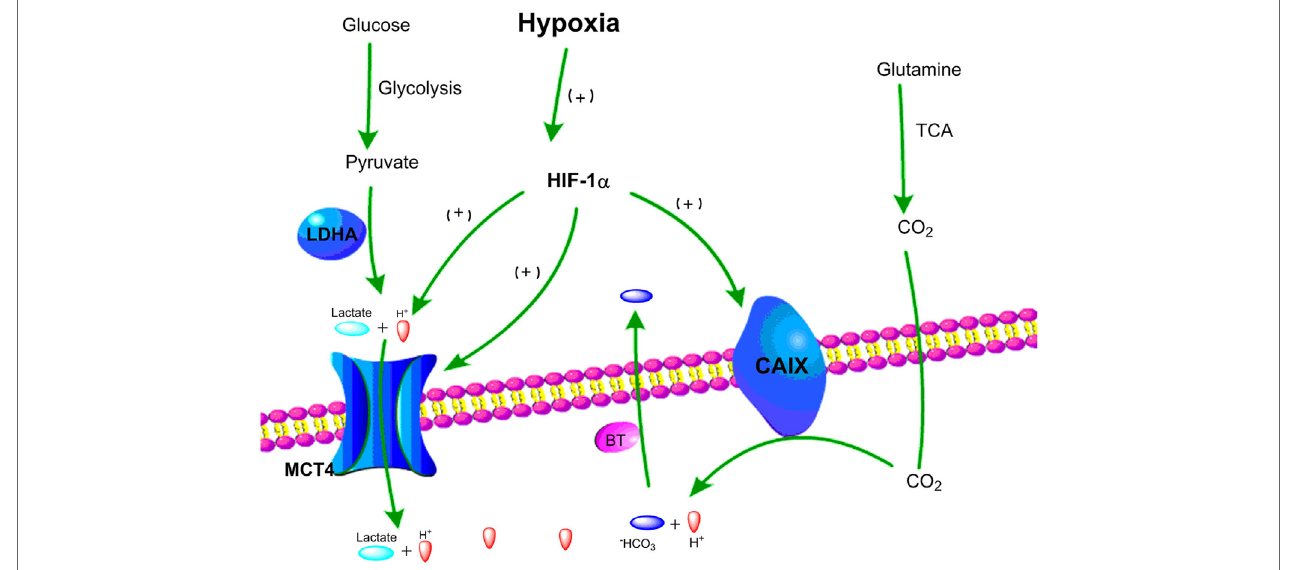
FigURe 2 | Schematic representation of two major pathways of hypoxia­driven extracellular acidity by tumor cells. (1) Under hypoxic conditions, glucose goes through glycolysis and produces pyruvate, which is mainly converted to lactic acid by lactate dehydrogenase A (LDHA). Lactic acid is exported by MCT4 resulting in acidification of the tumor microenvironment. (2) Under hypoxic conditions, glutamine goes through tricarboxylic acid (TCA) cycle and releases CO 2 , which can be converted into HCO 3 − and H + . HCO 3 − is transported back to tumor cells by bicarbonate transporters (BT), and accumulation of extracellular H + leads to tumor